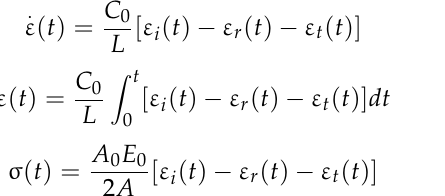
Figure 2. SHPB test principle.